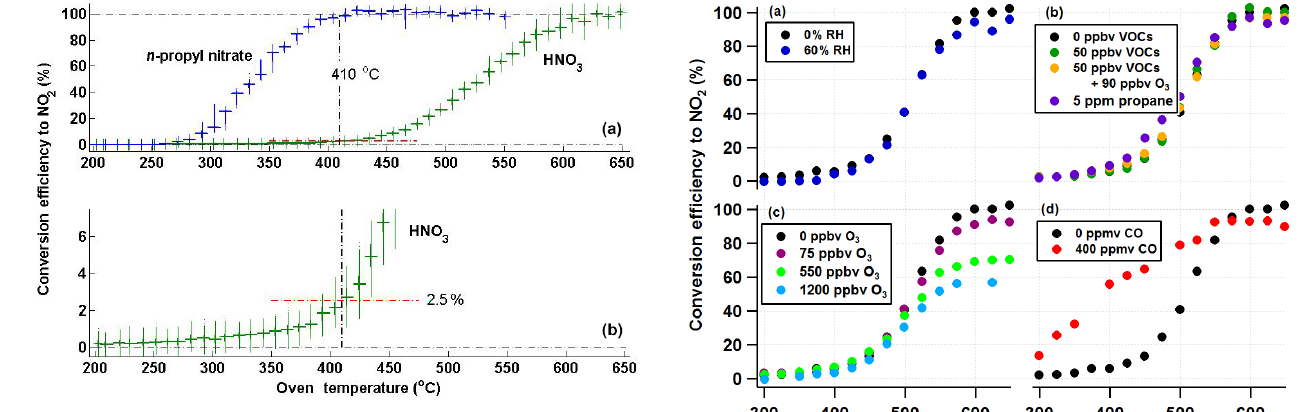
Figure 4. HNO 3 and n -propyl nitrate thermograms taken with the Berkeley TD-LIF instrument used in the NASA DISCOVER-AQ California mission. (b) Only HNO 3 with the y axis expanded to illustrate the dissociation onset. The oven is from the instrument’s alkyl nitrates channel. The flow rate was approximately 2slpm, and the measurement set point was 410 ◦ C. The dataset was corrected for the 2.5% dissociation of HNO 3 in the alkyl nitrates channel. A different oven was used for HNO 3 at a set point of 620 ◦ C.